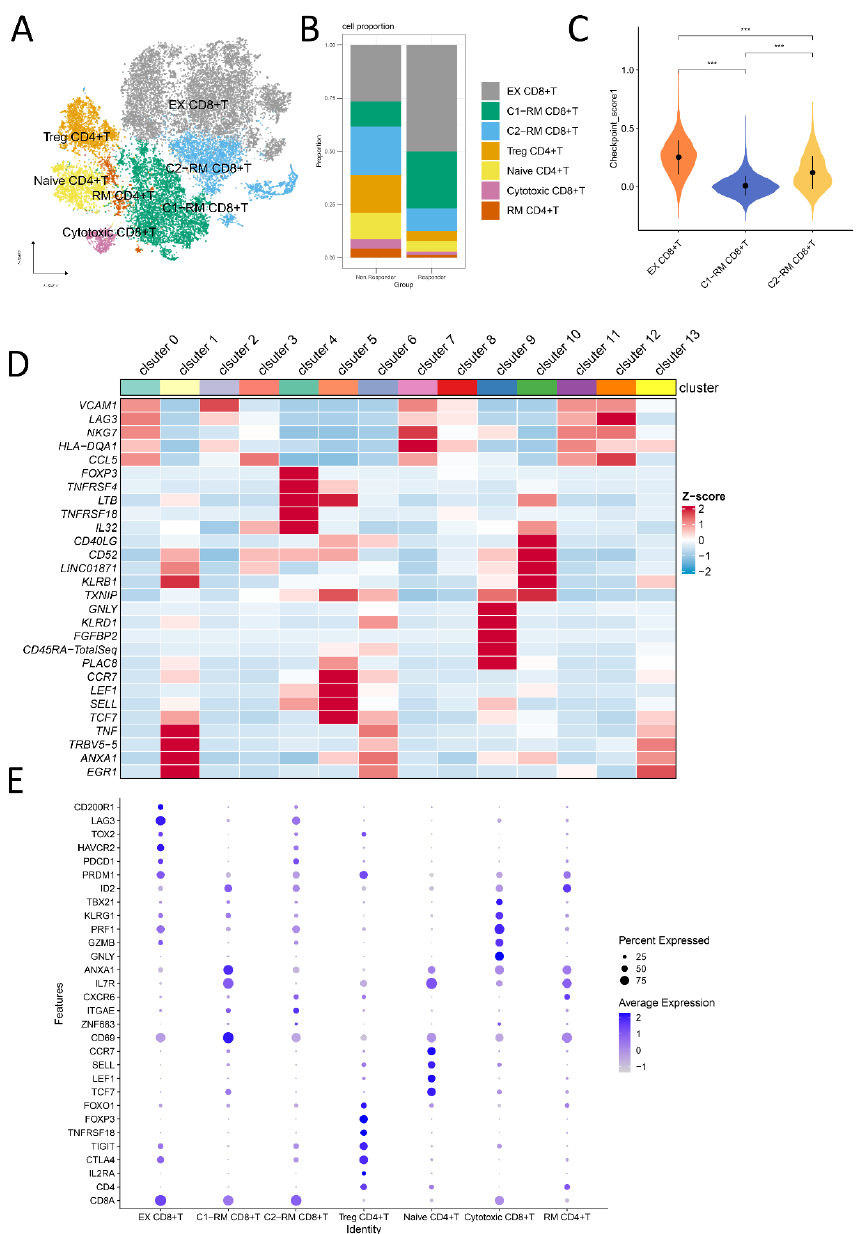
Figure 1. Single-cell RNA-seq profiling of anti-PD-1 responder and non-responder. ( A ): 27,707 high- quality CD4 + T and CD8 + T cells were classified into seven types of cells via the t-SNE dimensionality reduction algorithm based on canonical cell markers. ( B ): The stacking histogram displayed the difference in the distribution of seven types of T cells between the responder and non-responder. ( C ): Enrichment analysis of immune checkpoint genes of C1-RM CD8 + T, C2-RM CD8 + T, and EX CD8 + T clusters, indicating that EX CD8 + T had the highest score, followed by C2-RM CD8 + T, and C1-RM CD8 + T had the lowest score (*** means p < 0.001) ( D ): Heatmap depicting expression of top five marker genes among 14 clusters, the color represents the averaged scaled expression value. ( E ): Canonical markers of seven different cell types (exhausted CD8 + T cells, cluster1-resident memory CD8 + T cells, cluster2-resident memory CD8 + T cells, CD4 + CD25 + FOXP3 + regulatory T cells, naive CD4 + T cells, cytotoxic CD8 + T cells, and resident memory CD4 + T cells) are displayed in the bubble diagram, in which dot size and color represent the percentage of marker gene expression and the averaged scaled expression value,